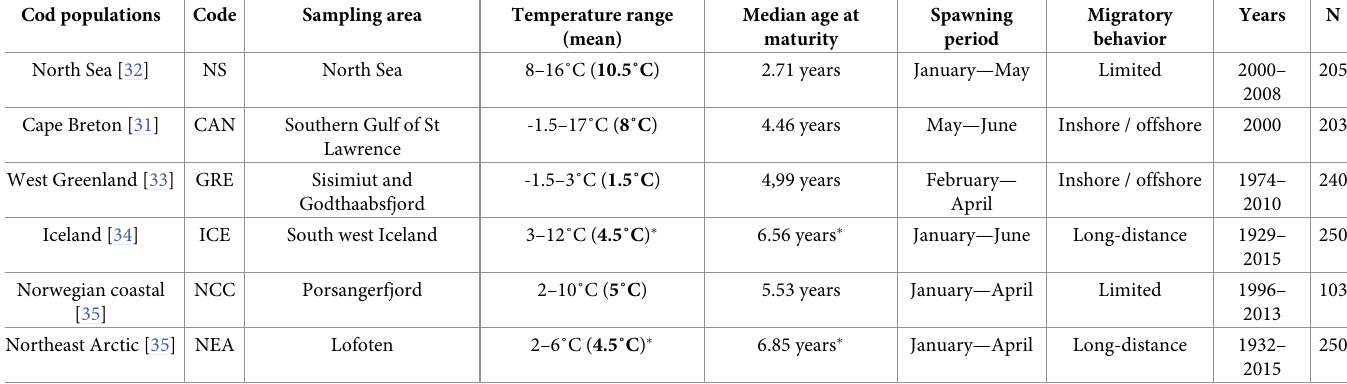
Table 1. Sampling area and environmental and life history traits of the cod populations whose otoliths were used in this